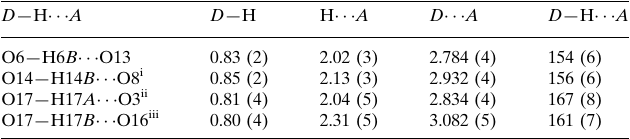
Hydrogen-bond geometry (A˚ , (cid:3)